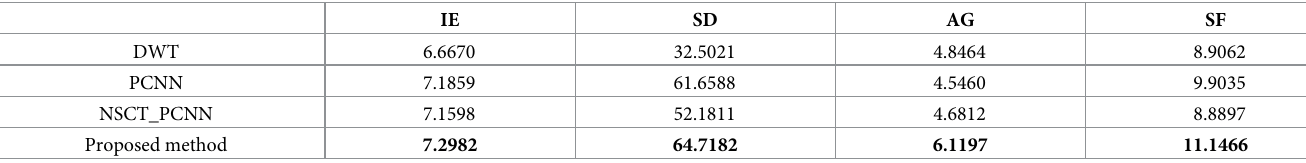
Table 2. Objective evaluation of the second group of images. IE SD